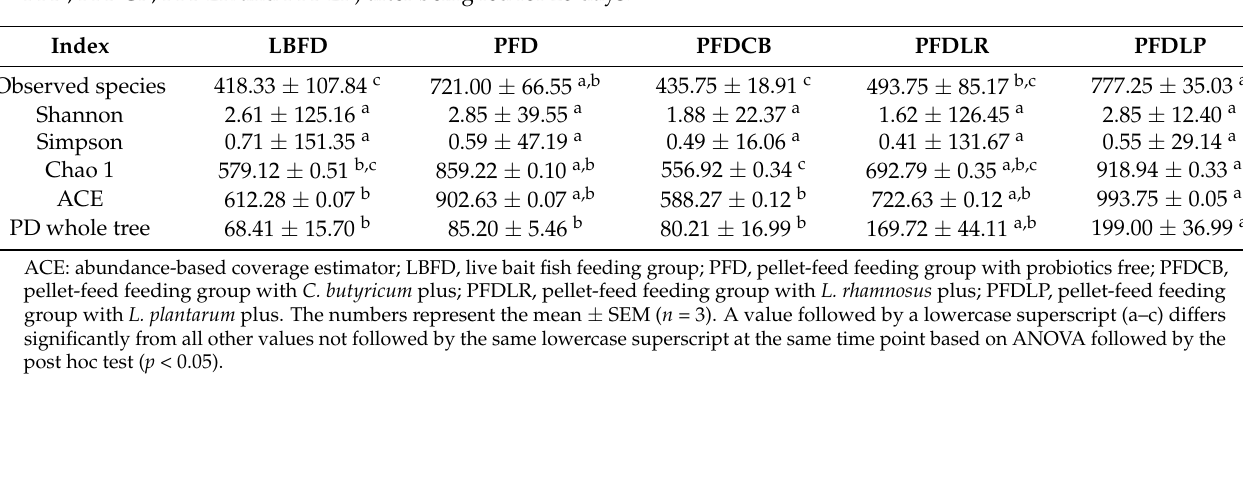
Table 2. Richness and diversity indices of mandarin fish intestinal microbial populations in different feeding groups (LBFD, PFD, PFDCB, PFDLR and PFDLP) after being fed for 28 days.